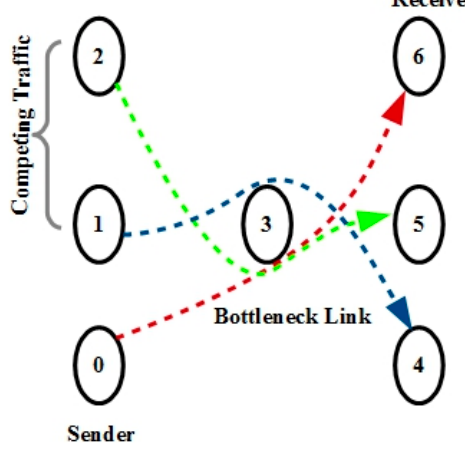
Figure 10. Dumbbell topology.